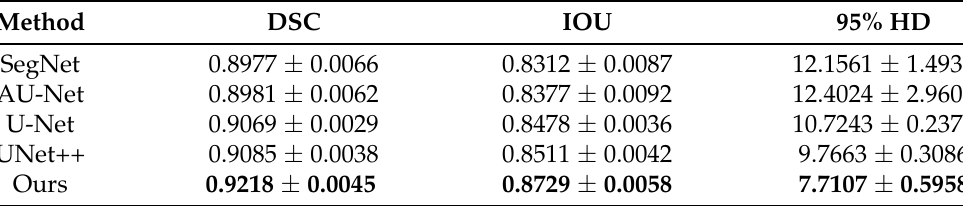
Table 1. Quantitative comparison of different methods on the test set.